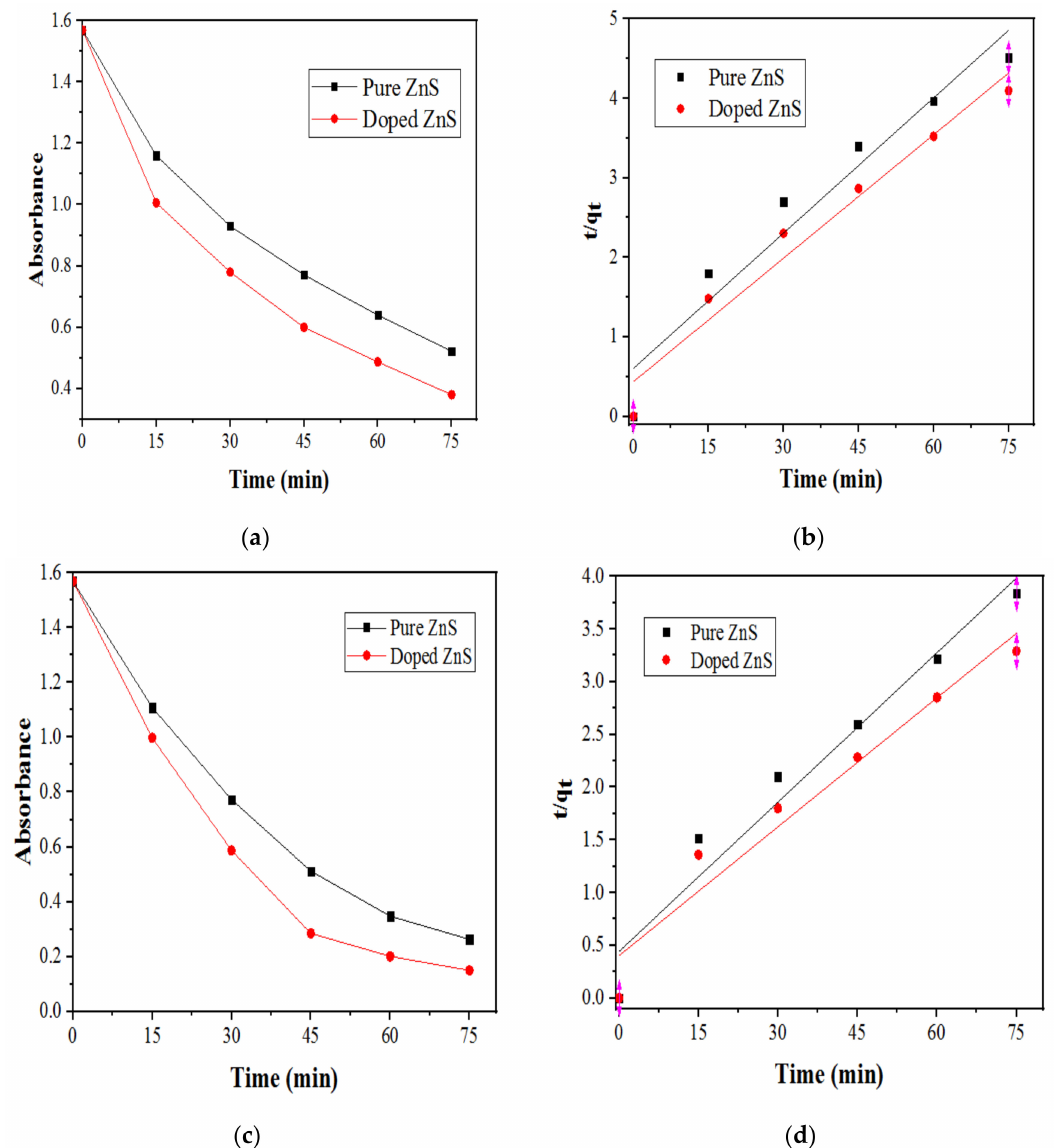
Figure 10. ( a ) SDB absorbance changes at maximum wavelength ( λ max = 560 nm), ( b ) kinetic model for the ultrasound assisted degradation in the presence of pure and Mn 2+ :ZnS Qds, under optimum conditions (15 mL 70 ppm of SDB, pH 6, 75 min ultrasound irradiation, 40 mg Qds, 40 kHz), ( c ) SDB absorbance changes at absorption maximum ( λ max = 560 nm) and ( d ) kinetic model for the ultrasound and UV light assisted degradation in the presence of pure and Mn 2+ :ZnS Qds at optimum conditions (15 mL of 70 ppm SDB, pH 6, 75 min ultrasound with UV light irradiation, 40 mg Qds, 40